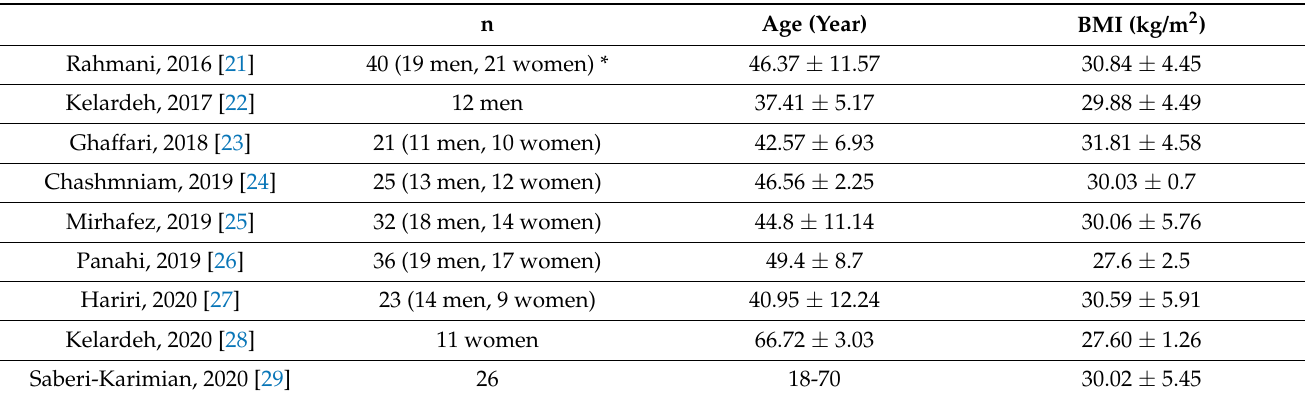
Table 2. Characteristics of studied